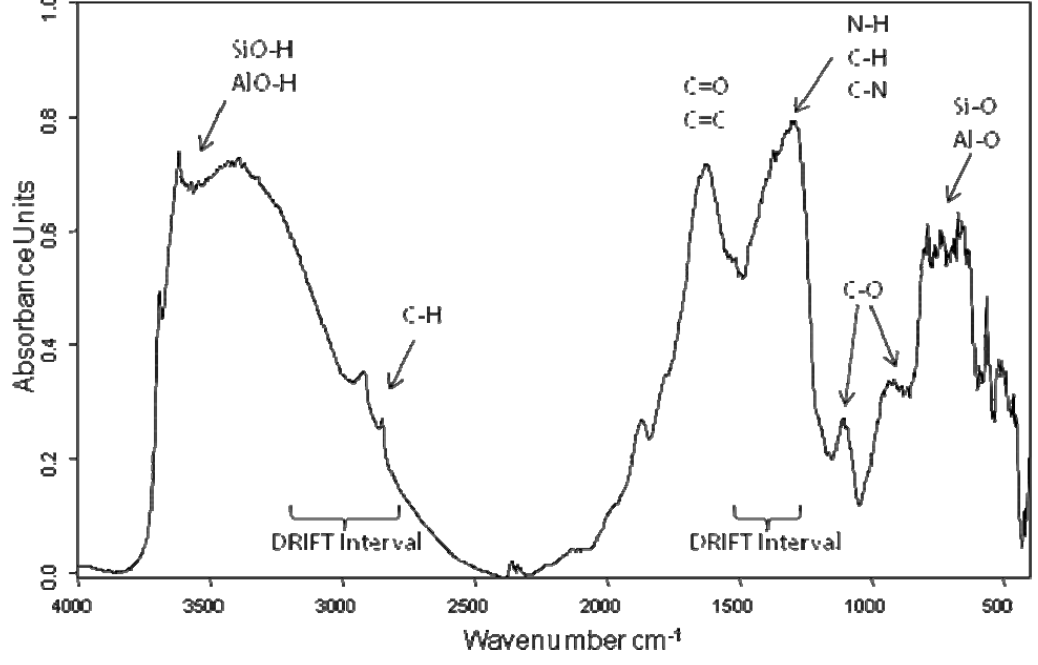
Figure 2. DRIFT spectrum with assignment of principal bands investigated and the spectral width regions used for the PLS analysis of the selected soils.